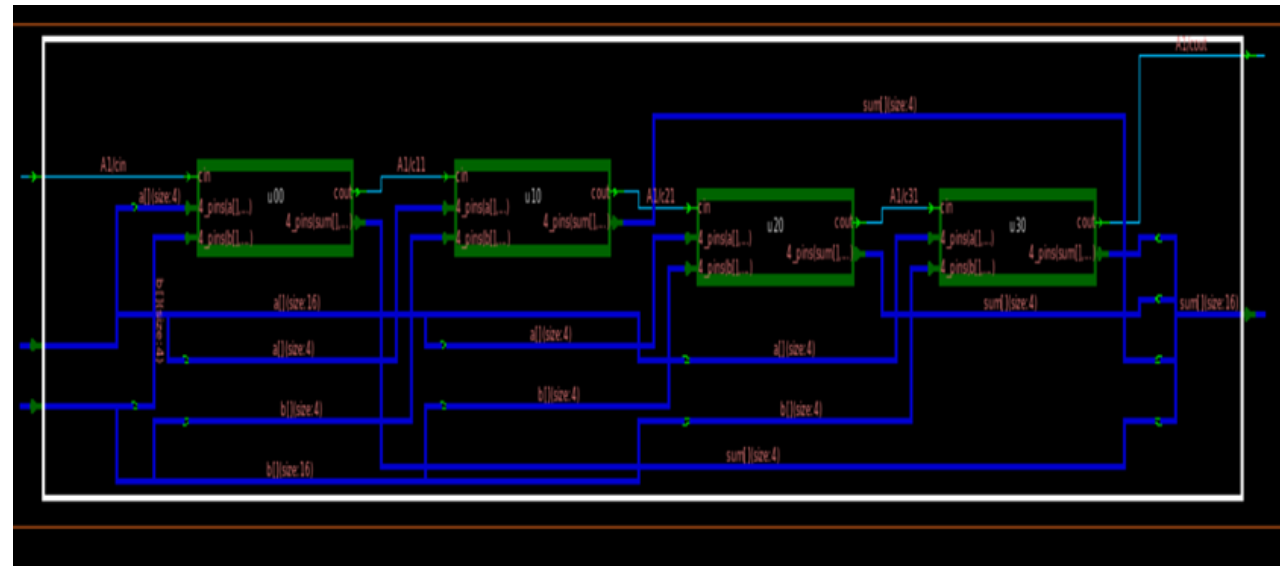
Figure 2. The 16-bit ripple carry full adder block diagram.